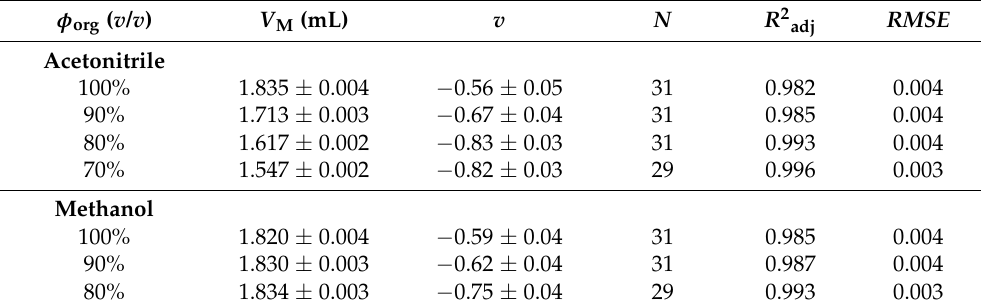
Table 2. Hold-up volumes and v coefficients ( ± standard deviation) of the ZIC-HILIC column at the different mobile phase compositions (HILIC behavior) obtained from the fittings of retention to Equation